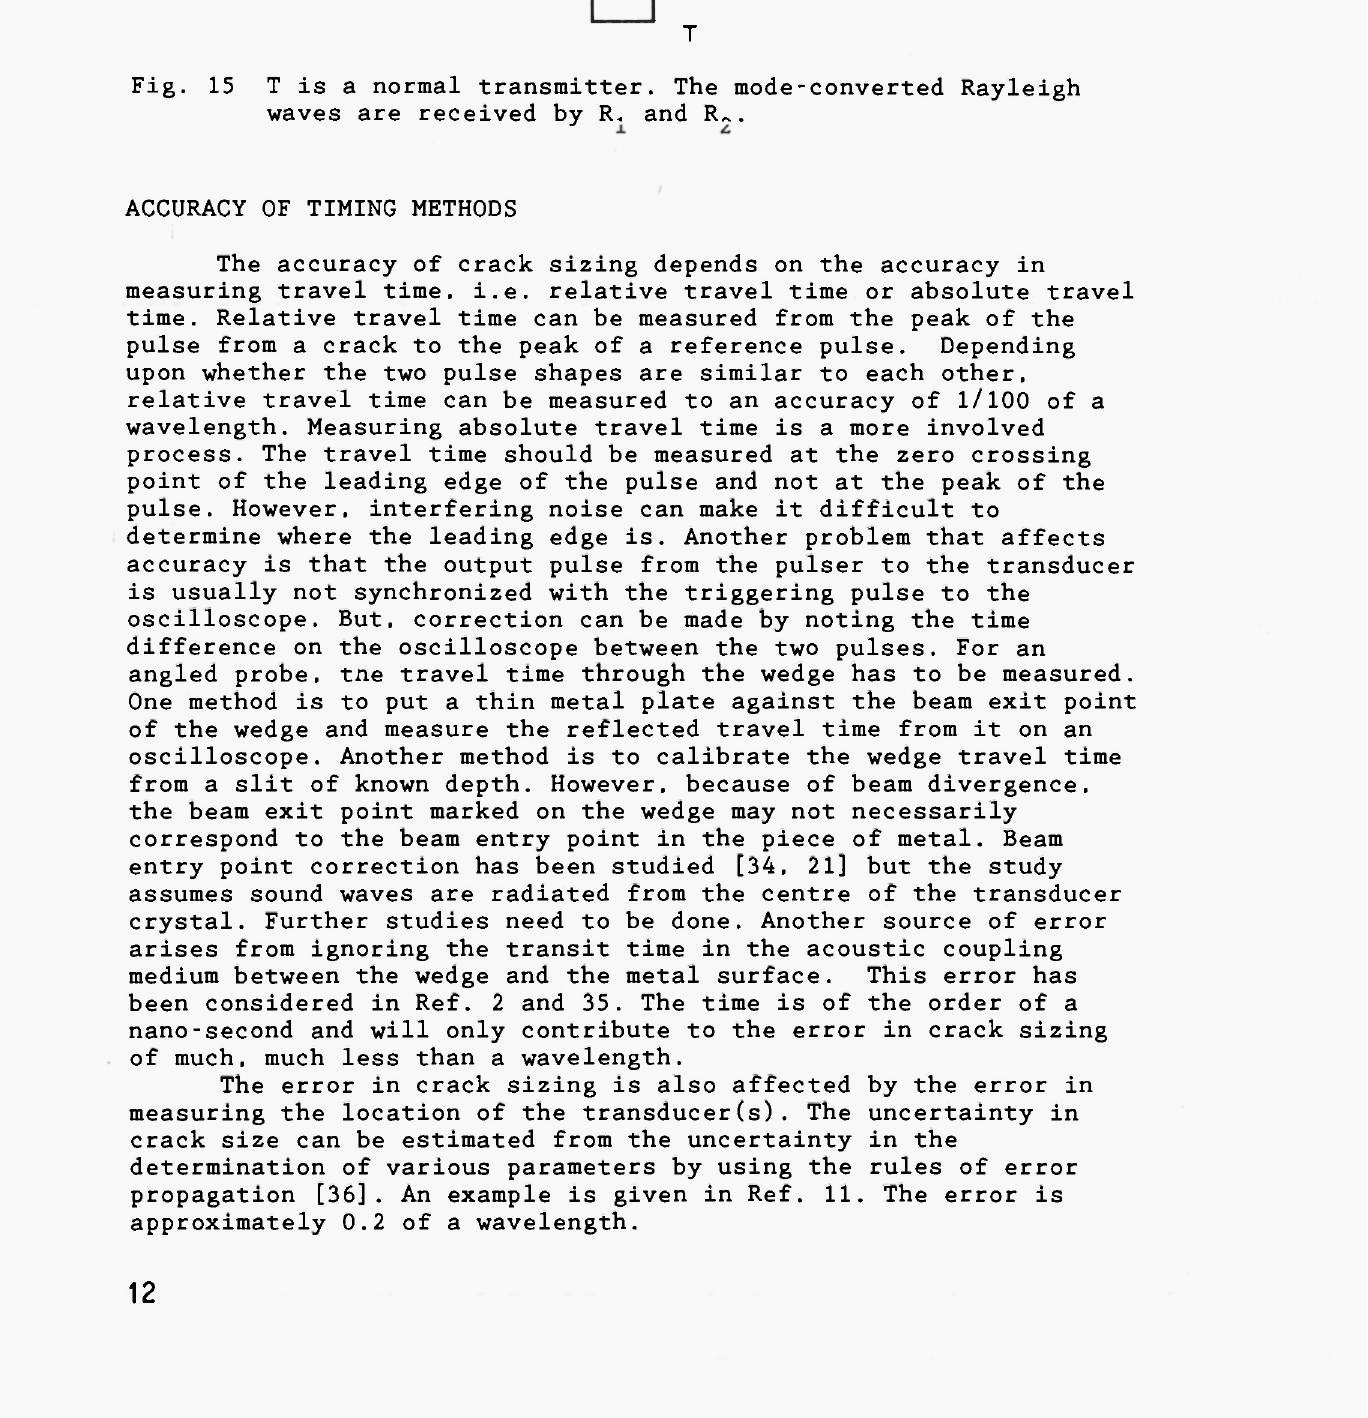
Fig. 15 Τ is a normal transmitter. The mode-converted Rayleigh waves are received by R. and